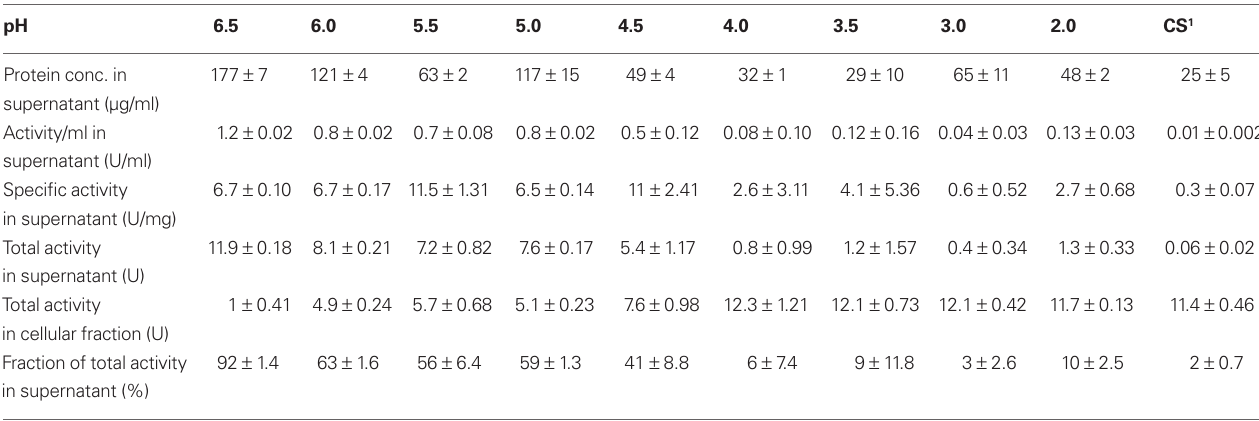
Table 2 | TTH activities in the cell-free supernatants following incubation of 0.86 g each of A. ambivalens cells in 10 ml of buffer of different pH values; average values from two to three enzyme